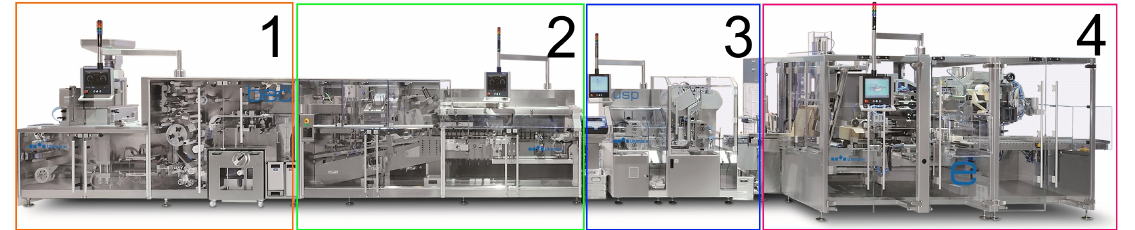
Figure 2. An Uhlmann pharmaceutical packaging line with its production